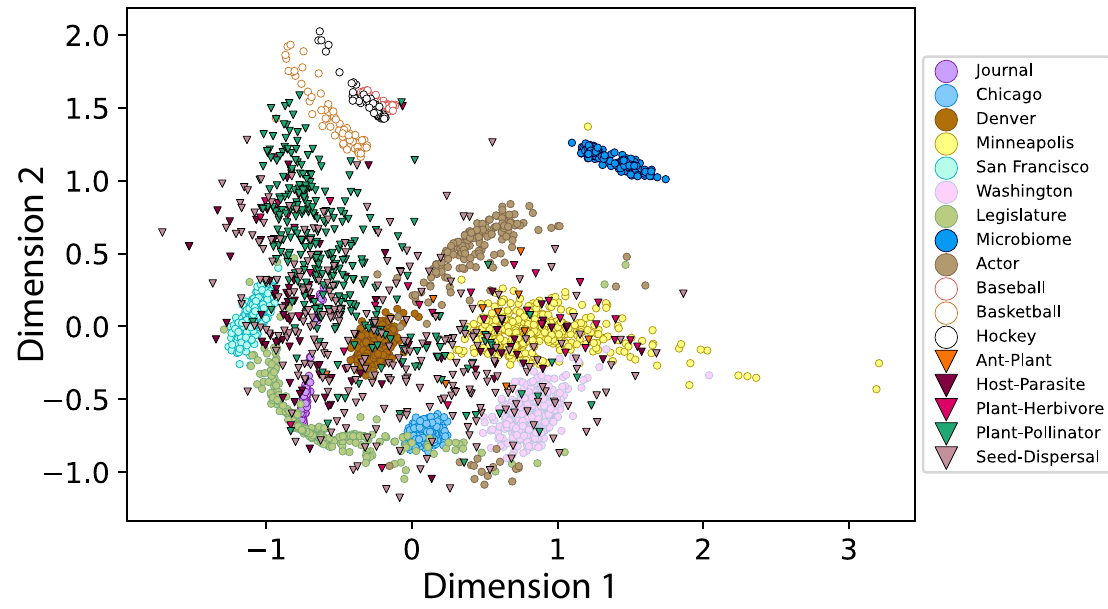
Fig 4. Multidimensional scaling of the pairwise directed graphlet correlation distance-13 (DGCD-13) between all bipartite networks ( n = 3,476). Except for species interaction networks (triangles), only networks that formed clear groups in the plot are uniquely identified by color. Each point in the plot is a single network. The data and code needed to generate this figure can be found in